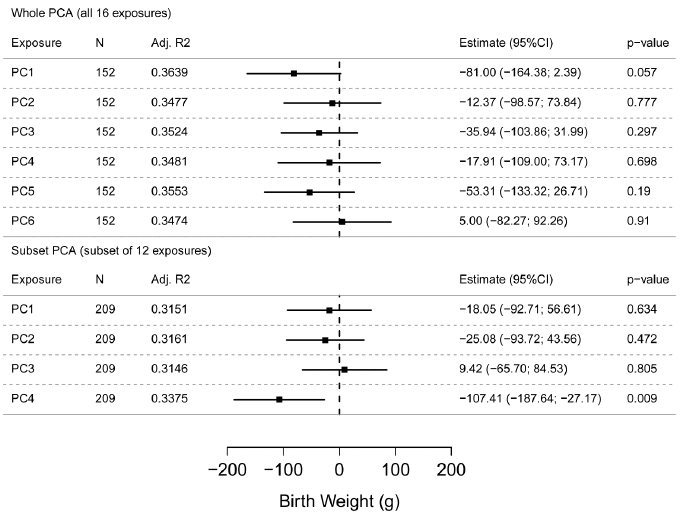
Figure 3. Results of the Principal Component Regression (PCR) for the whole PCA (all 16 exposures) and subset PCA (subset of 12 exposures). The estimated effects (for an increase of the Z-score of the principal component with the interquartile rang) and corresponding confidence limits (95%) are shown by squares and lines, respectively. Significance (at the 5% level) is demonstrated when the confidence interval does not include 0. The models are adjusted for gestational age, child’s sex, smoking of the mother during pregnancy, parity and maternal prepregnancy BMI. PC = Principal component; N = Number of samples; Adj. R 2 = Adjusted R 2 .